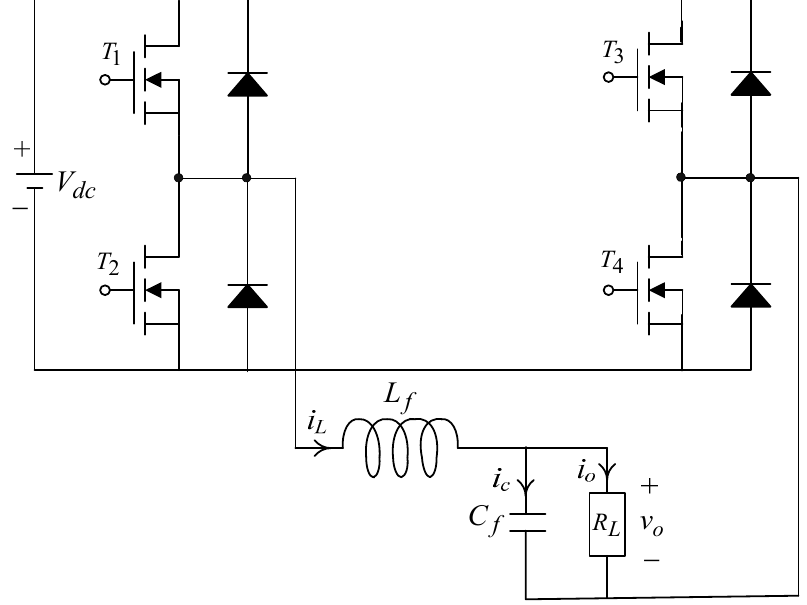
Figure 1. Frame diagram relating to a single-phase sine-wave inverter. For a single-phase sine-wave inverter with an inductor-capacitor filter, the dynamical action may be characterized by the state equations defining x 1 = v o and x 2 =